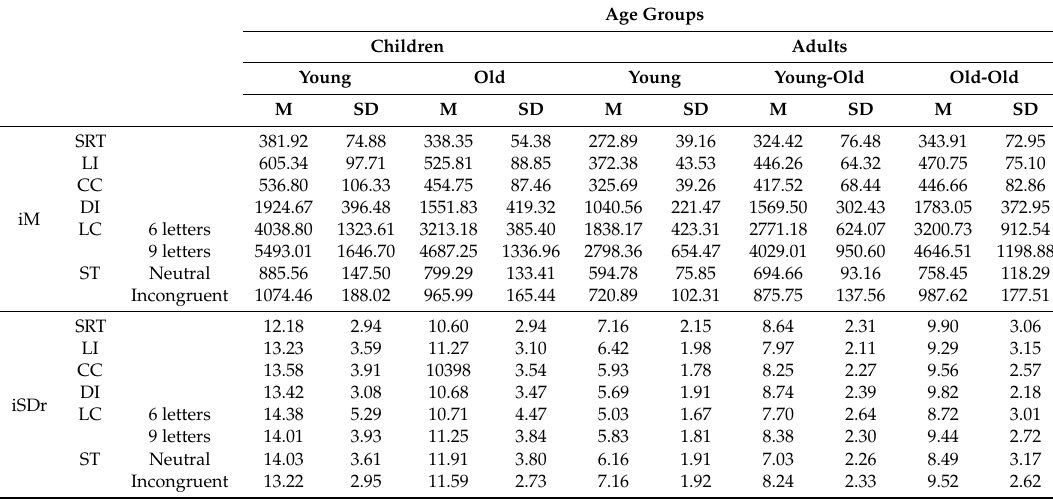
Table A3. Reaction time tasks: Means (iM) and intra-individual standard deviation of residual scores (iSDr) by Age group (five